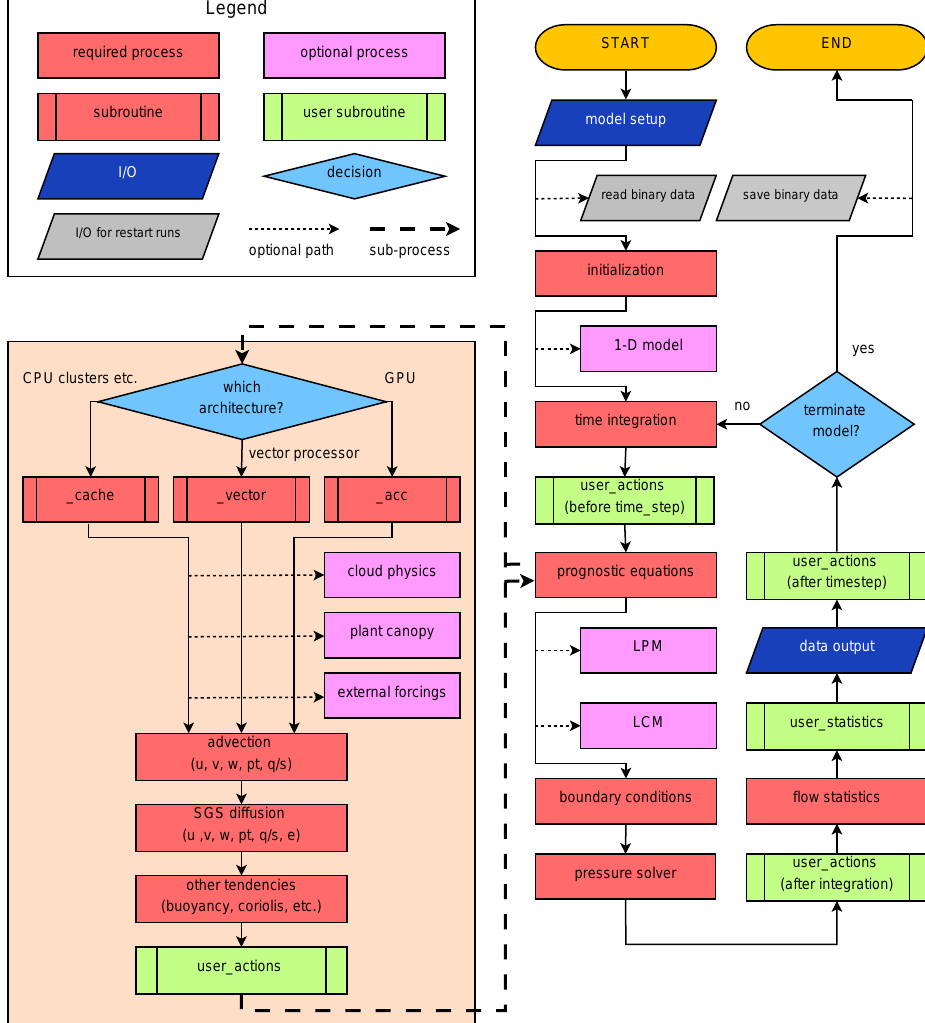
Figure 10. Simplified flowchart of